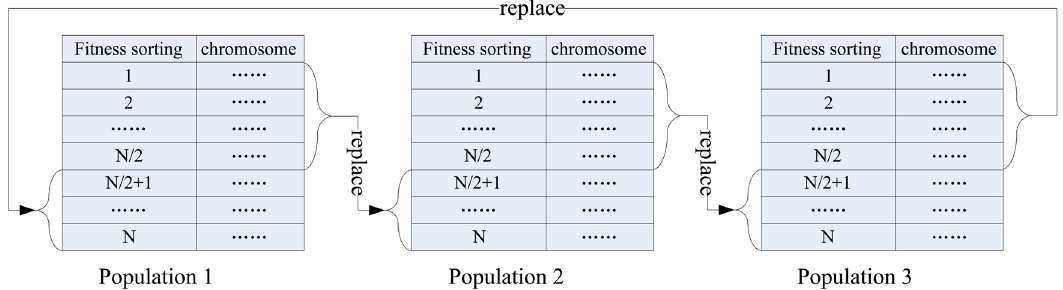
Figure 3: The operation fl ow of coevolutionary operation of three